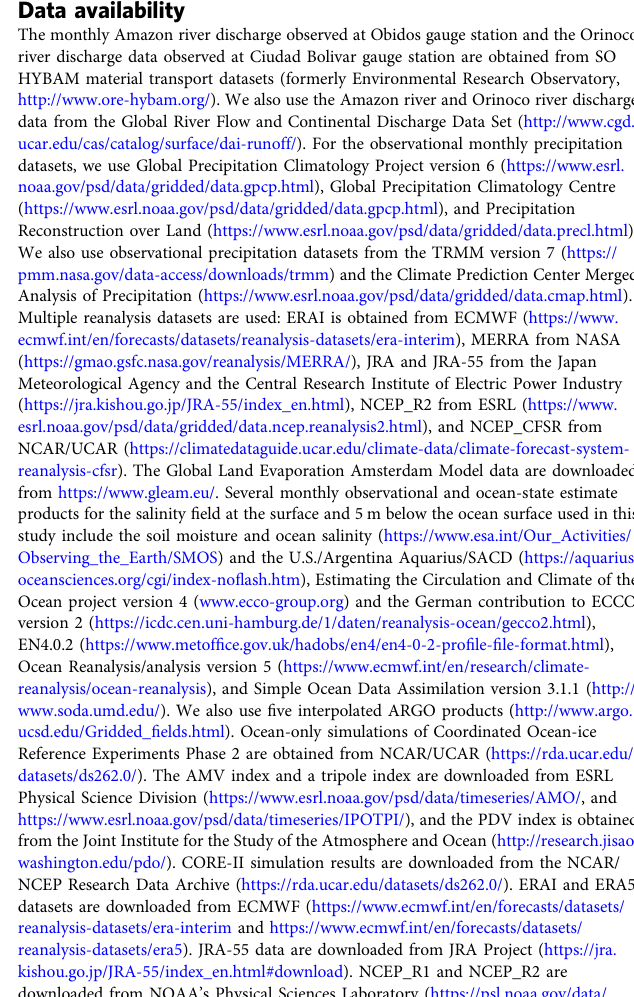
the FFT approach described